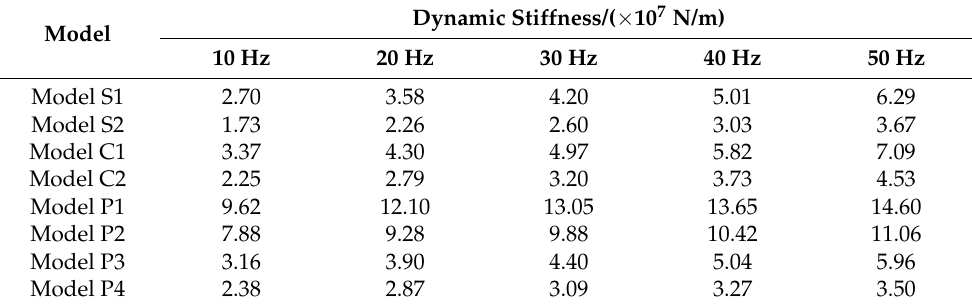
Figure 7. Dynamic stiffnesses of the eight foundation models: ( a ) spread foundations; ( b ) caisson foundations; and ( c ) grouped pile foundations. Table 1. K d values of all foundation models for frequencies in the range of 10–50 Hz.